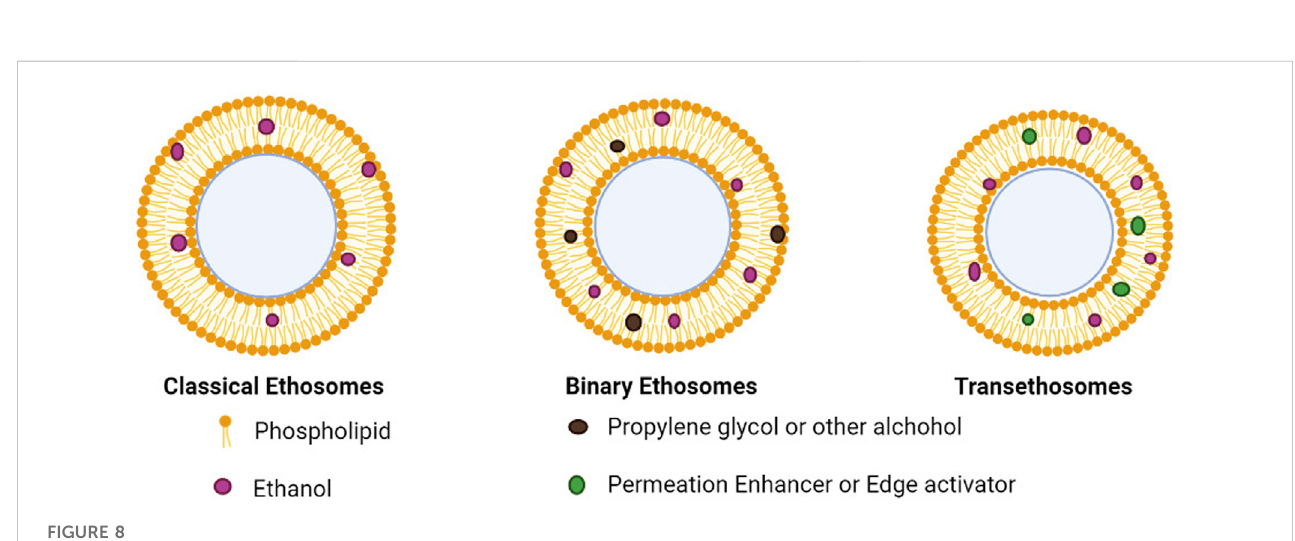
FIGURE 8 Types of